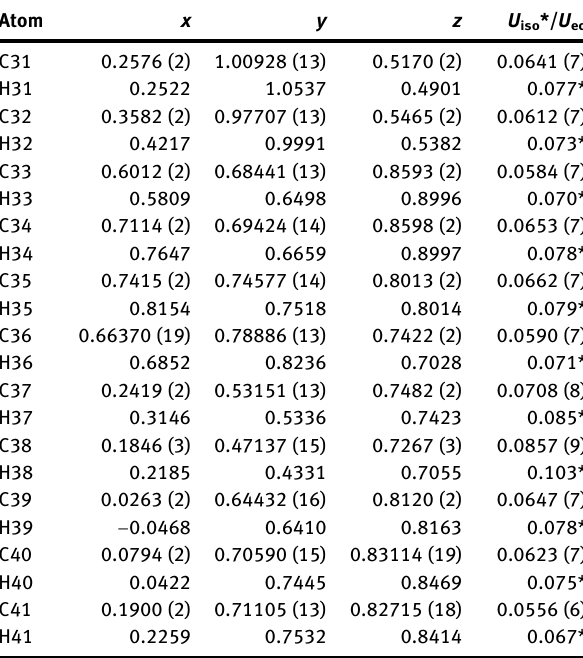
Table  : Fractional atomic coordinates and isotropic or equivalent isotropic displacement parameters (Å 